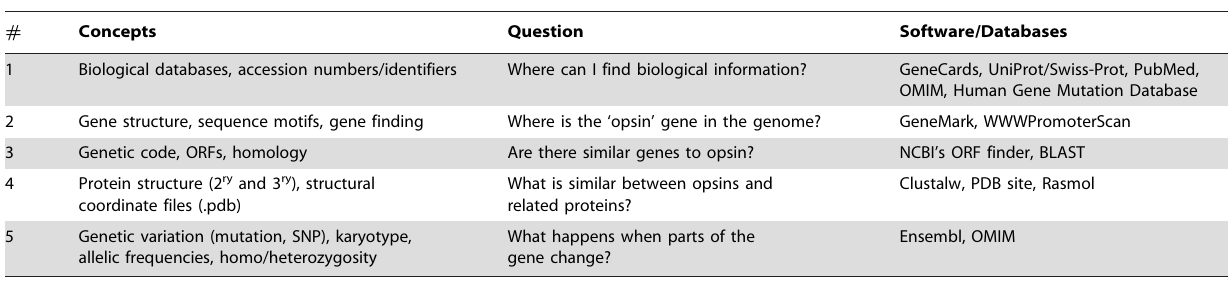
Table 1. Individual activities in the project